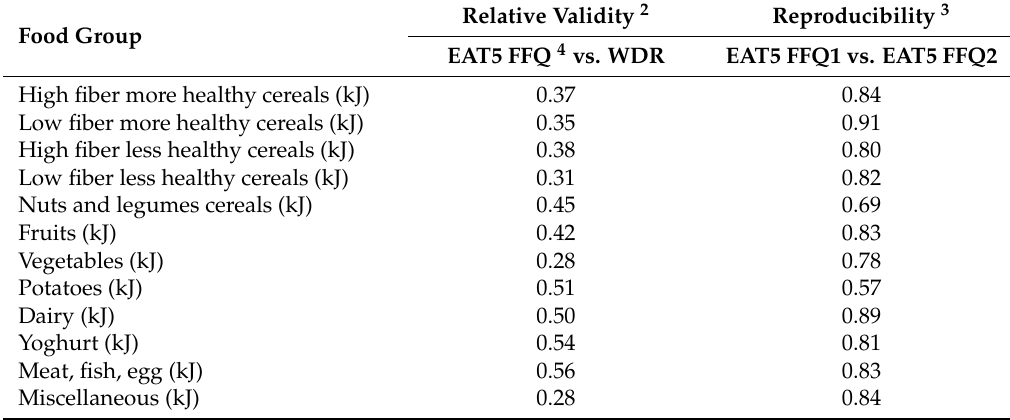
Table 6. Food group (energy contribution) correlations between the EAT5 FFQ and WDR ( n = 100), and reproducibility correlations ( n = 99) in 5-year old children 1